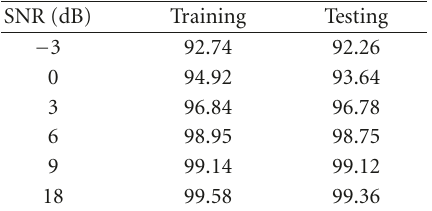
Table 5: Performances of the identifier with applying of GA.